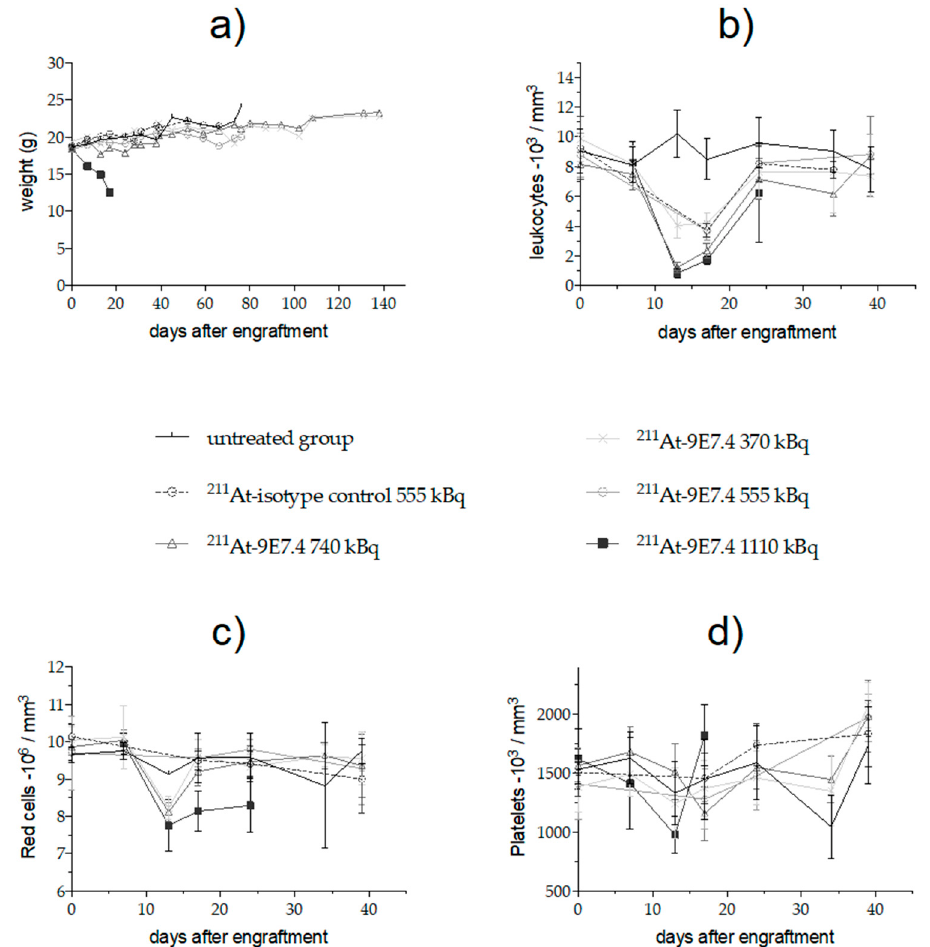
Figure 4. Weight ( a ) and hematologic toxicity of mice grafted with 10 6 5T33 MM cells then treated with 211 At-mAb. Leucocytes ( b ), red blood cells ( c ) and platelets ( d ) were analyzed using quantitative automated hematology analyzer and are given as means and SD of surviving mice.